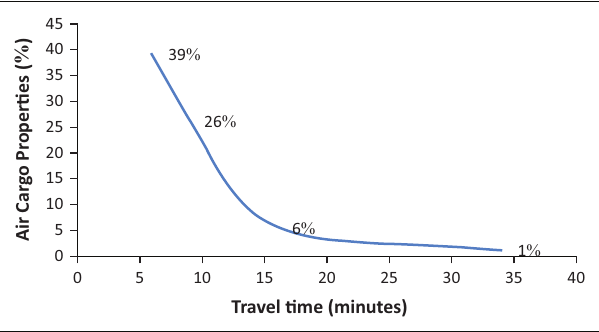
FIGURE 2: Relationship between travel time and percentage of air cargo